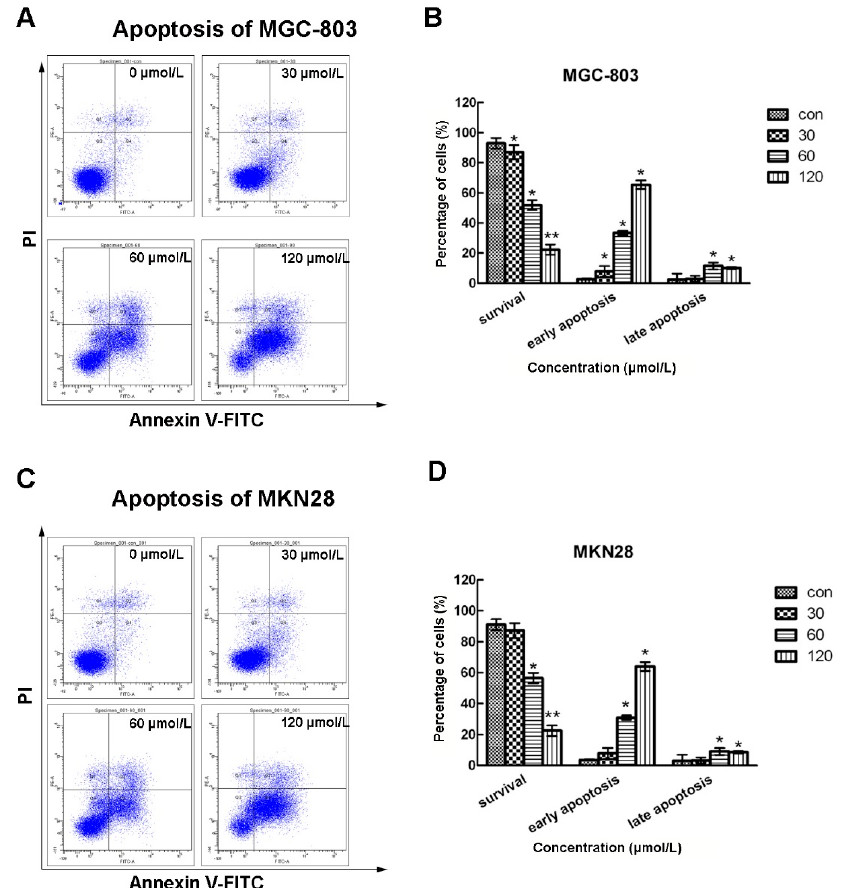
Figure 3. CVB-D induces apoptosis of MGC-803 and MKN28 cells. ( A , C ) Representative flow cytometry graphs indicating apoptosis patterns of CVB-D (0, 30, 60 and 120 µmol/L) treated MGC-803 ( A ); and MKN28 cells ( C ); ( B , D ) Statistic analysis of cells numbers at different populations of CVB-D treated MGC-803 ( B ); and MKN28 cells ( D ). PI − /Annexin V − , survival cells; PI − /Annexin V + , early apoptotic cells; PI + /Annexin V + , late apoptotic cells. * p < 0.05, ** p < 0.01. Each experiment involved at least three replicates.